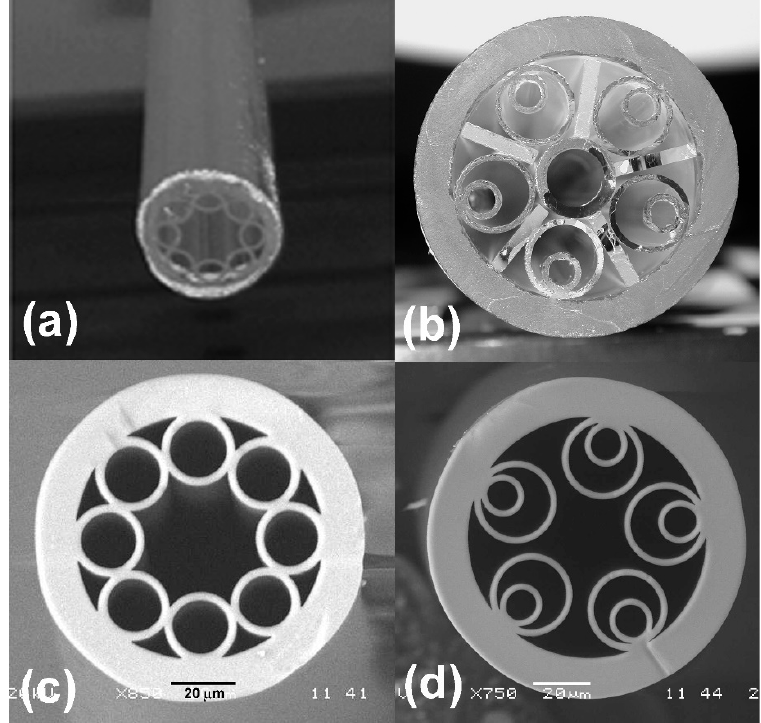
Figure 7. Cross sections of optical elements at the main stages of RF production: ( a ) Picture of the RF preform with single capillaries touched to each other; ( b ) Cross-section of the RF preform with silica elements between the double nested capillaries, Ø 25 mm; ( c ) SEM image of the RF cross section (drawn from the preform in Figure 7a); and, ( d ) SEM image of the RF cross section with double non-touching capillaries, Ø 110 μ m (from the preform in Figure 7b).